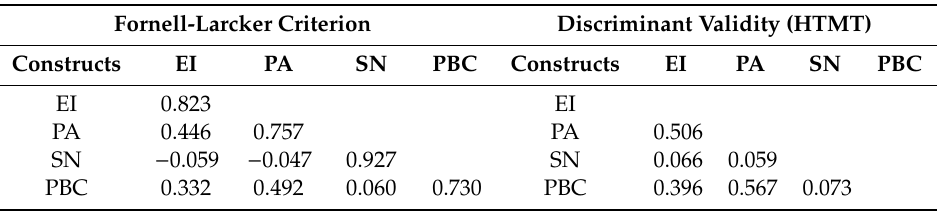
Table 5. Assessment of discriminant validity.